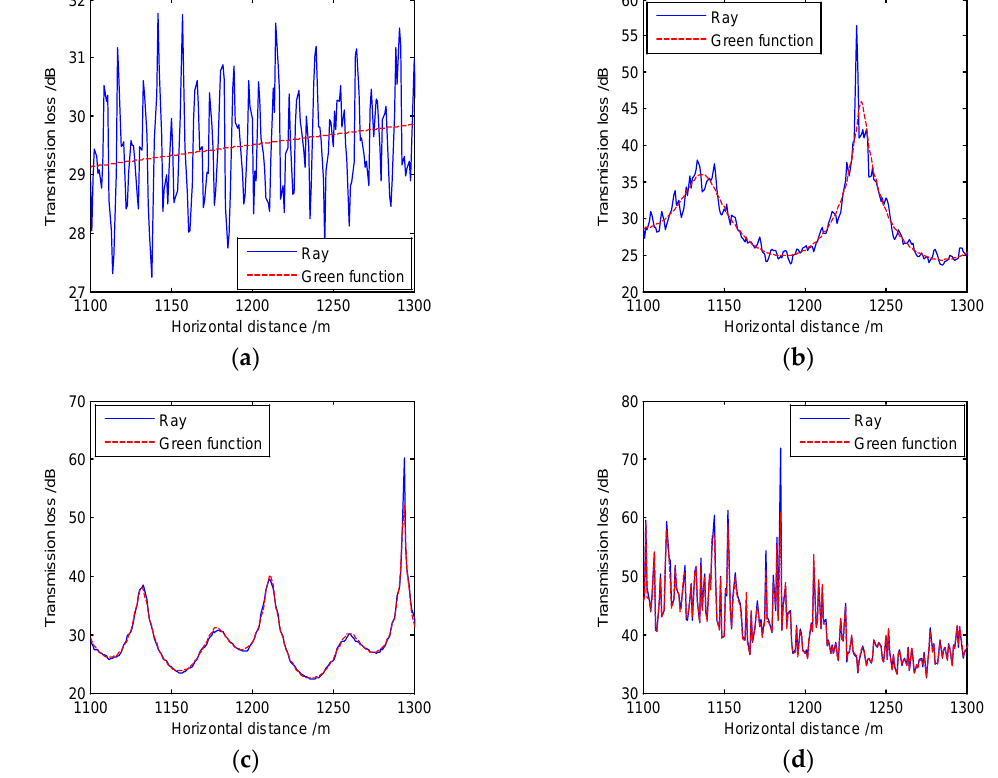
Figure 4. The field comparison chart after superposition at different frequencies and depths. ( a ) Comparison at 20 Hz and 50 m; ( b ) Comparison at 50 Hz and 50 m; ( c ) Comparison at 50 Hz and 100 m; ( d ) Comparison at 1000 Hz and 50 m.